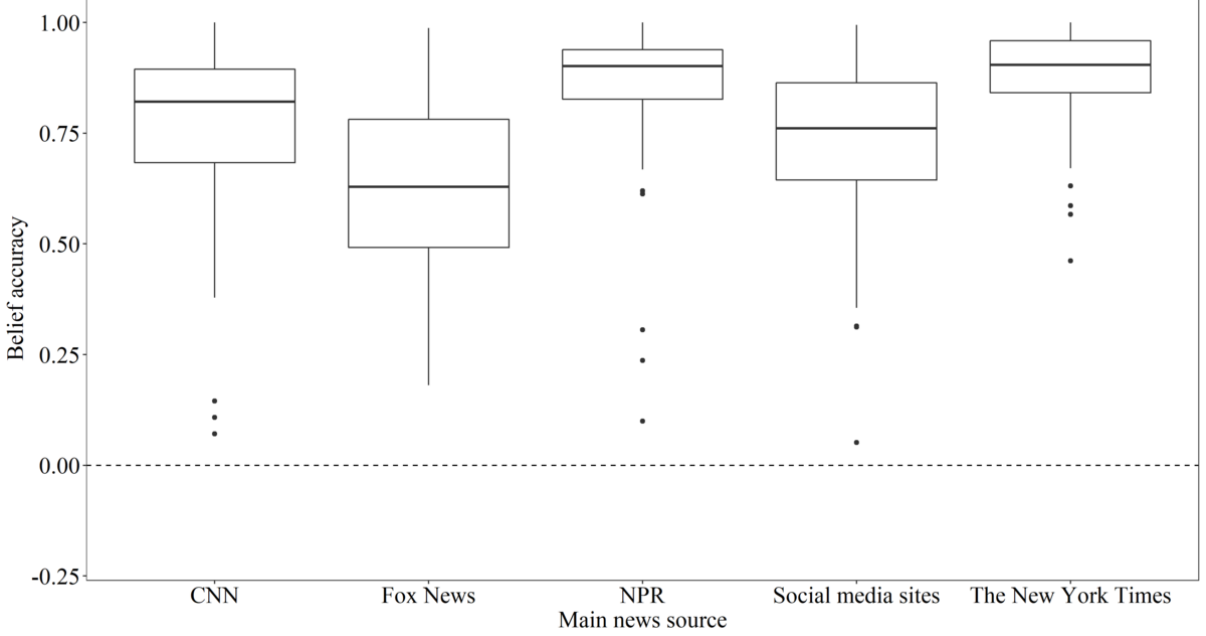
Figure 4. Box plot of raw (unadjusted) scores of belief accuracy (averaged over wave for plotting) by main news source. The belief accuracy scale ranged from –1, indicating completely inaccurate beliefs, to 1, indicating completely accurate